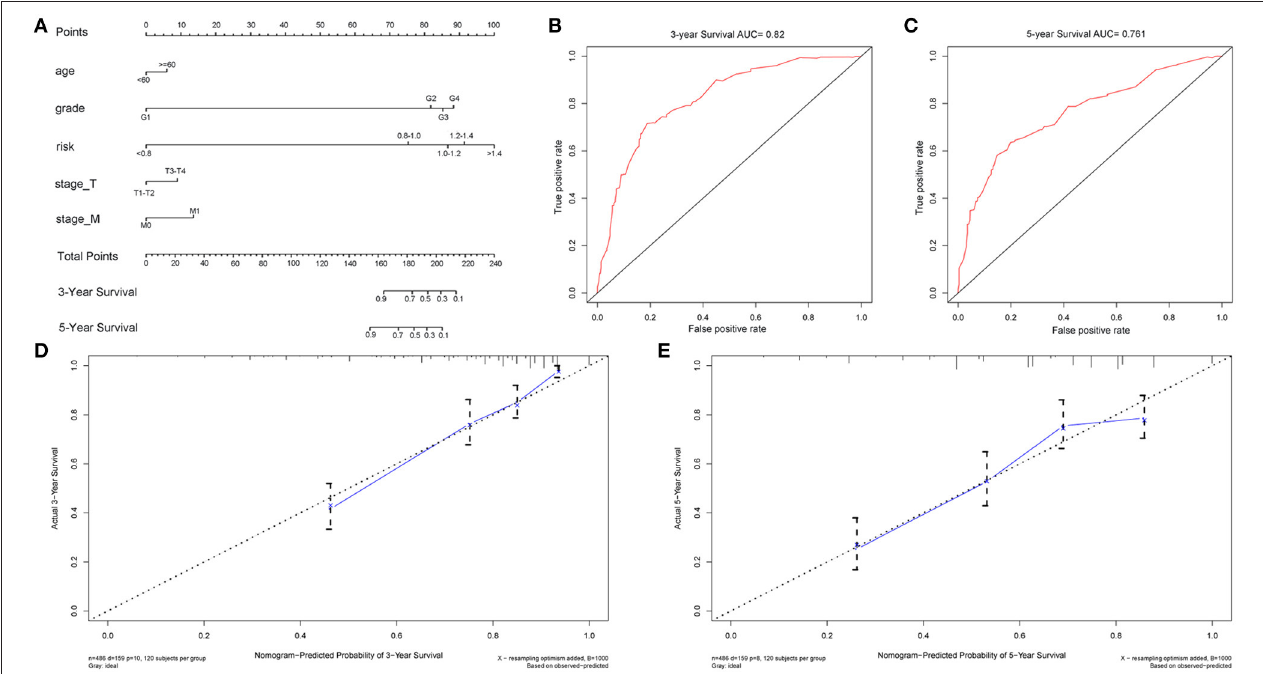
FIGURE 5 | Nomogram model constructed by independent prognostic factors predicting 3- and 5-year OS for ccRCC patients (A) , their corresponding ROC curves (B,C) , and corresponding calibration curves (D,E) for validation of the model.